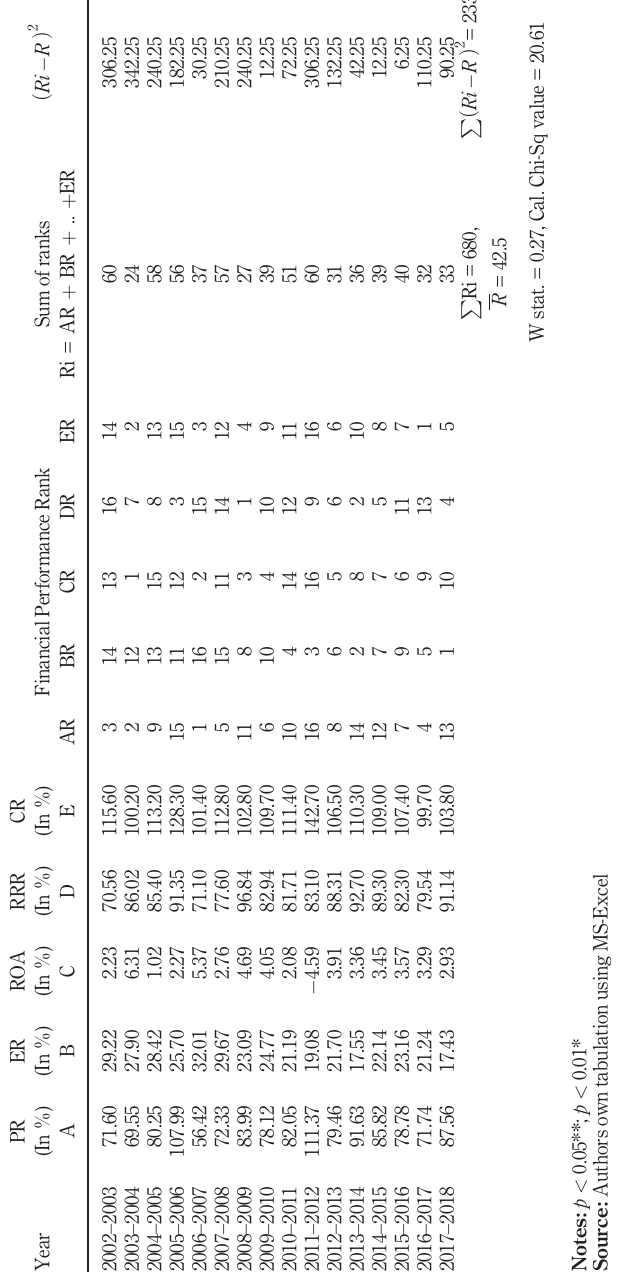
of concordance amongst the